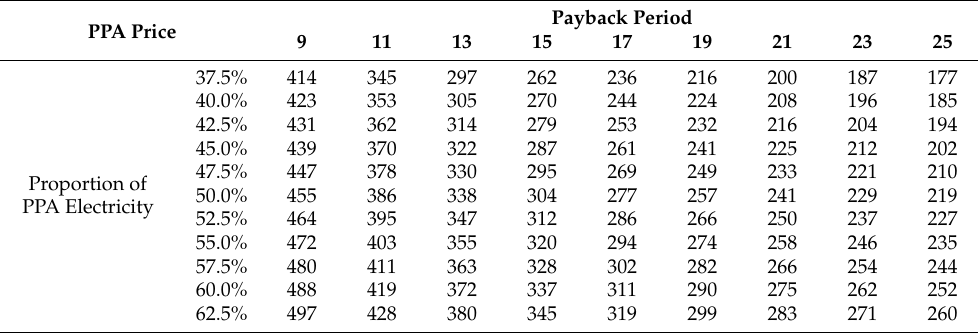
Table 6. Analysis of the Relationship between Contract Signing Proportion, Investment Payback Period and